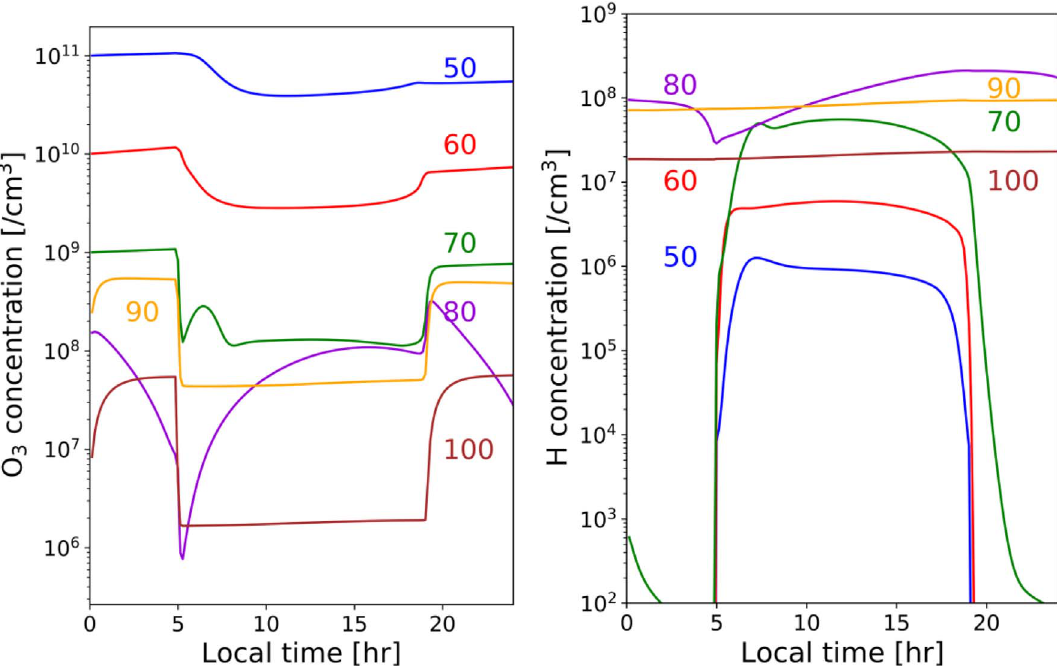
Fig. 2. Examples of molecules concentration evolution, O 3 on the left and H on the right. Ozone is strongly dependent on the solar cycle above 60 km. Below 80 km, H originates from the water vapor dissociation.